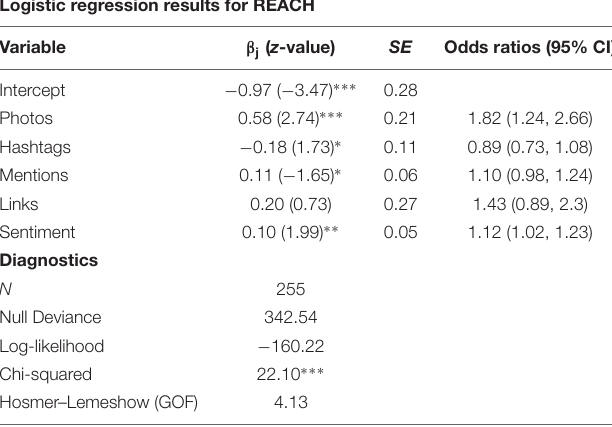
TABLE 8 | Logistic regression results for the dichotomous outcome variable